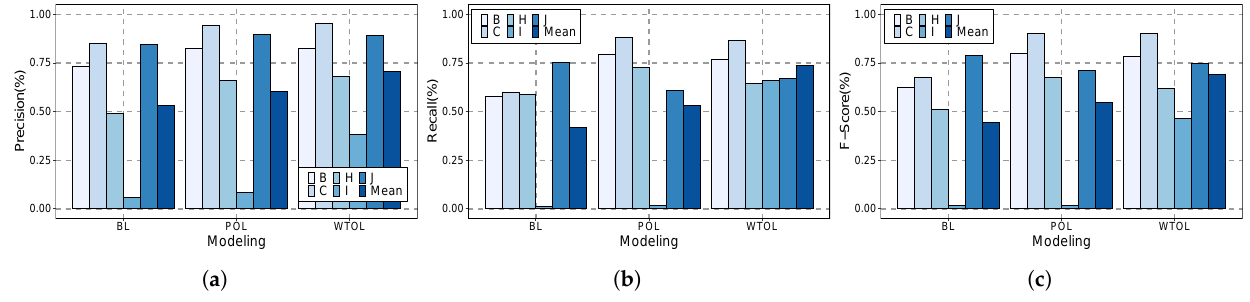
Figure 4. The inference results over time: ( a ) Precision ( b ) Recall, and ( c )